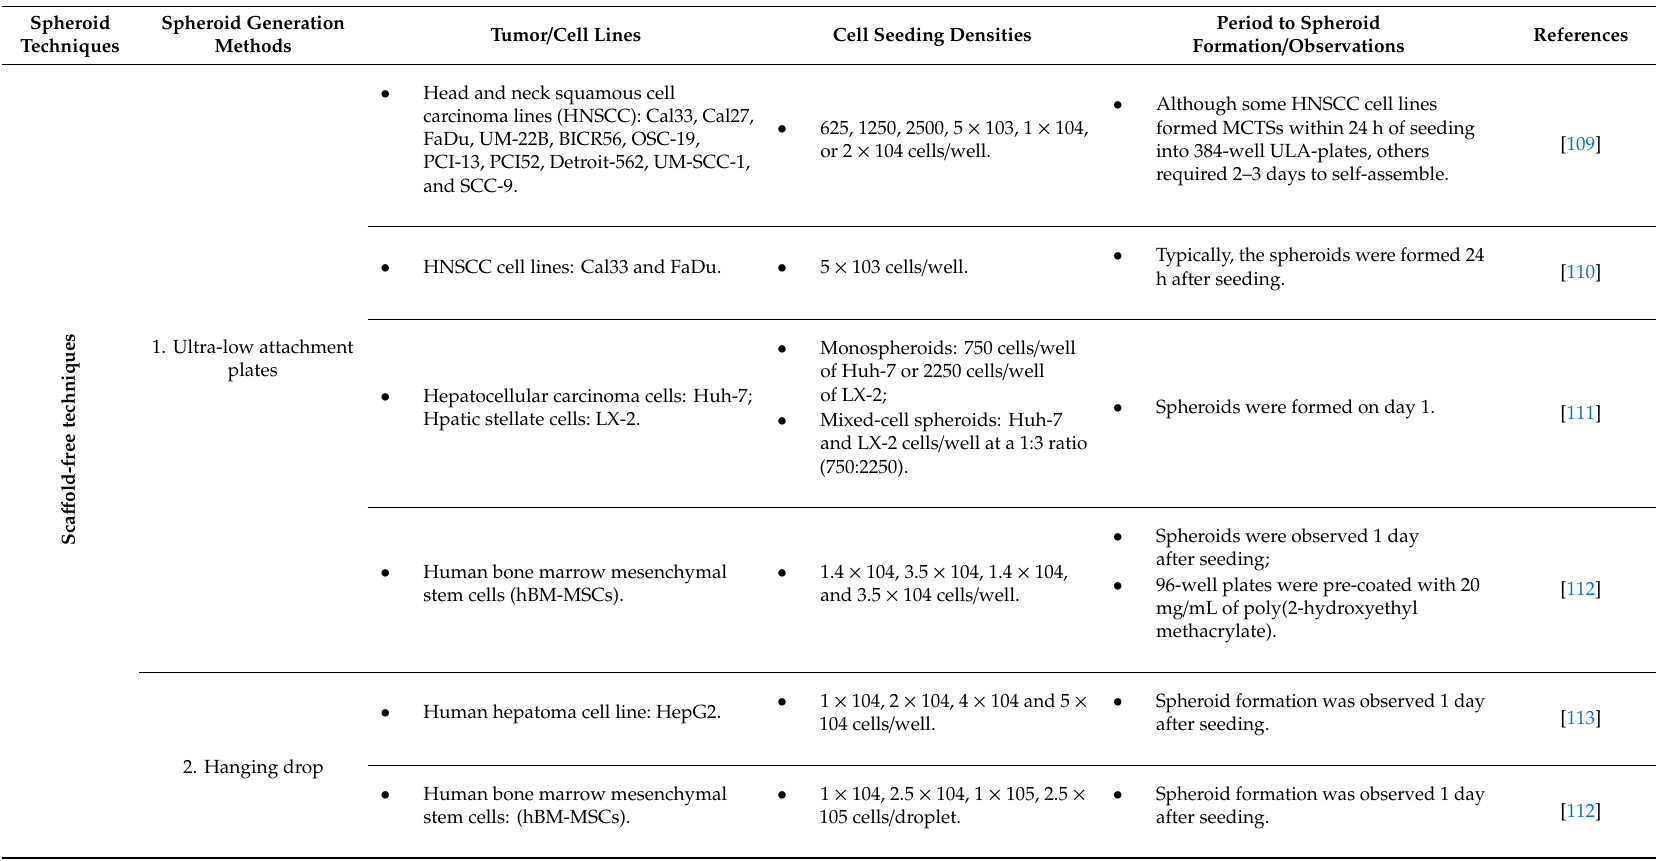
Table 2. Examples of tumors and respective cell lines, densities and time required for 3D cell culture formation by di ff erent spheroid generation methods. Spheroid